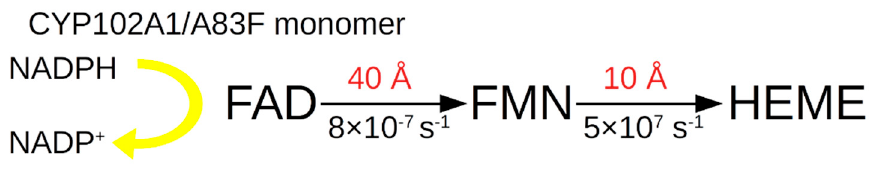
Figure 5. Scheme of electron transport in the electron transport chain of the CYP102A1/A83F monomer. As for A83F, it can be seen that the limiting factor for the electron transfer constant from FAD to heme is the large distance of 40 Å between FAD and FMN. Calculations show that for β = 1.06, k et between these PG is 8 × 10 − 7 s − 1 . It should be mentioned that k cat